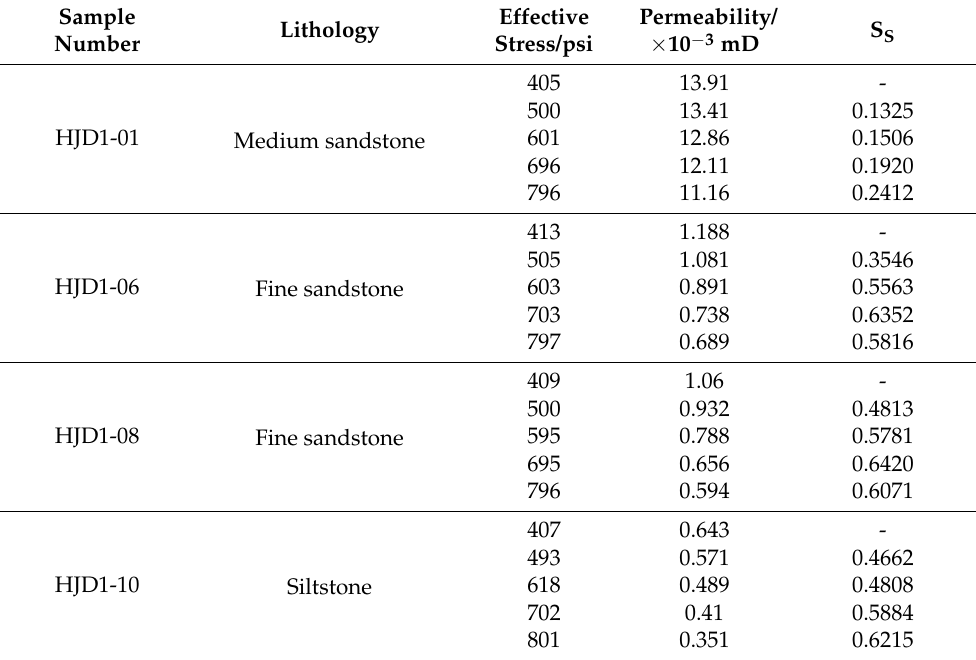
Table 5. Stress sensitivity coefficient (S S ) under different effective stress between 405 and 801